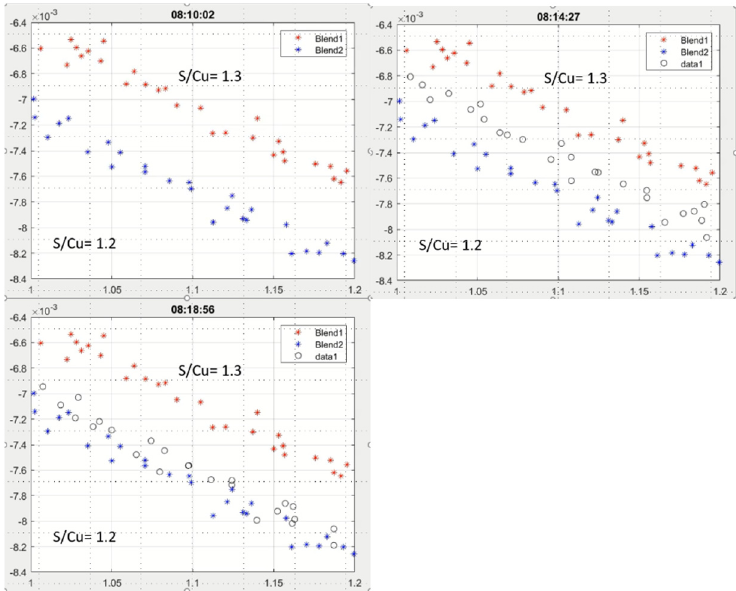
Figure 13. Two principal components (PC) showing the change of the charge from Blend 1 to Blend 2. With circles are the evolution of those PC. The change was schedule at 08:00 and started at 08:10 and took more than 9